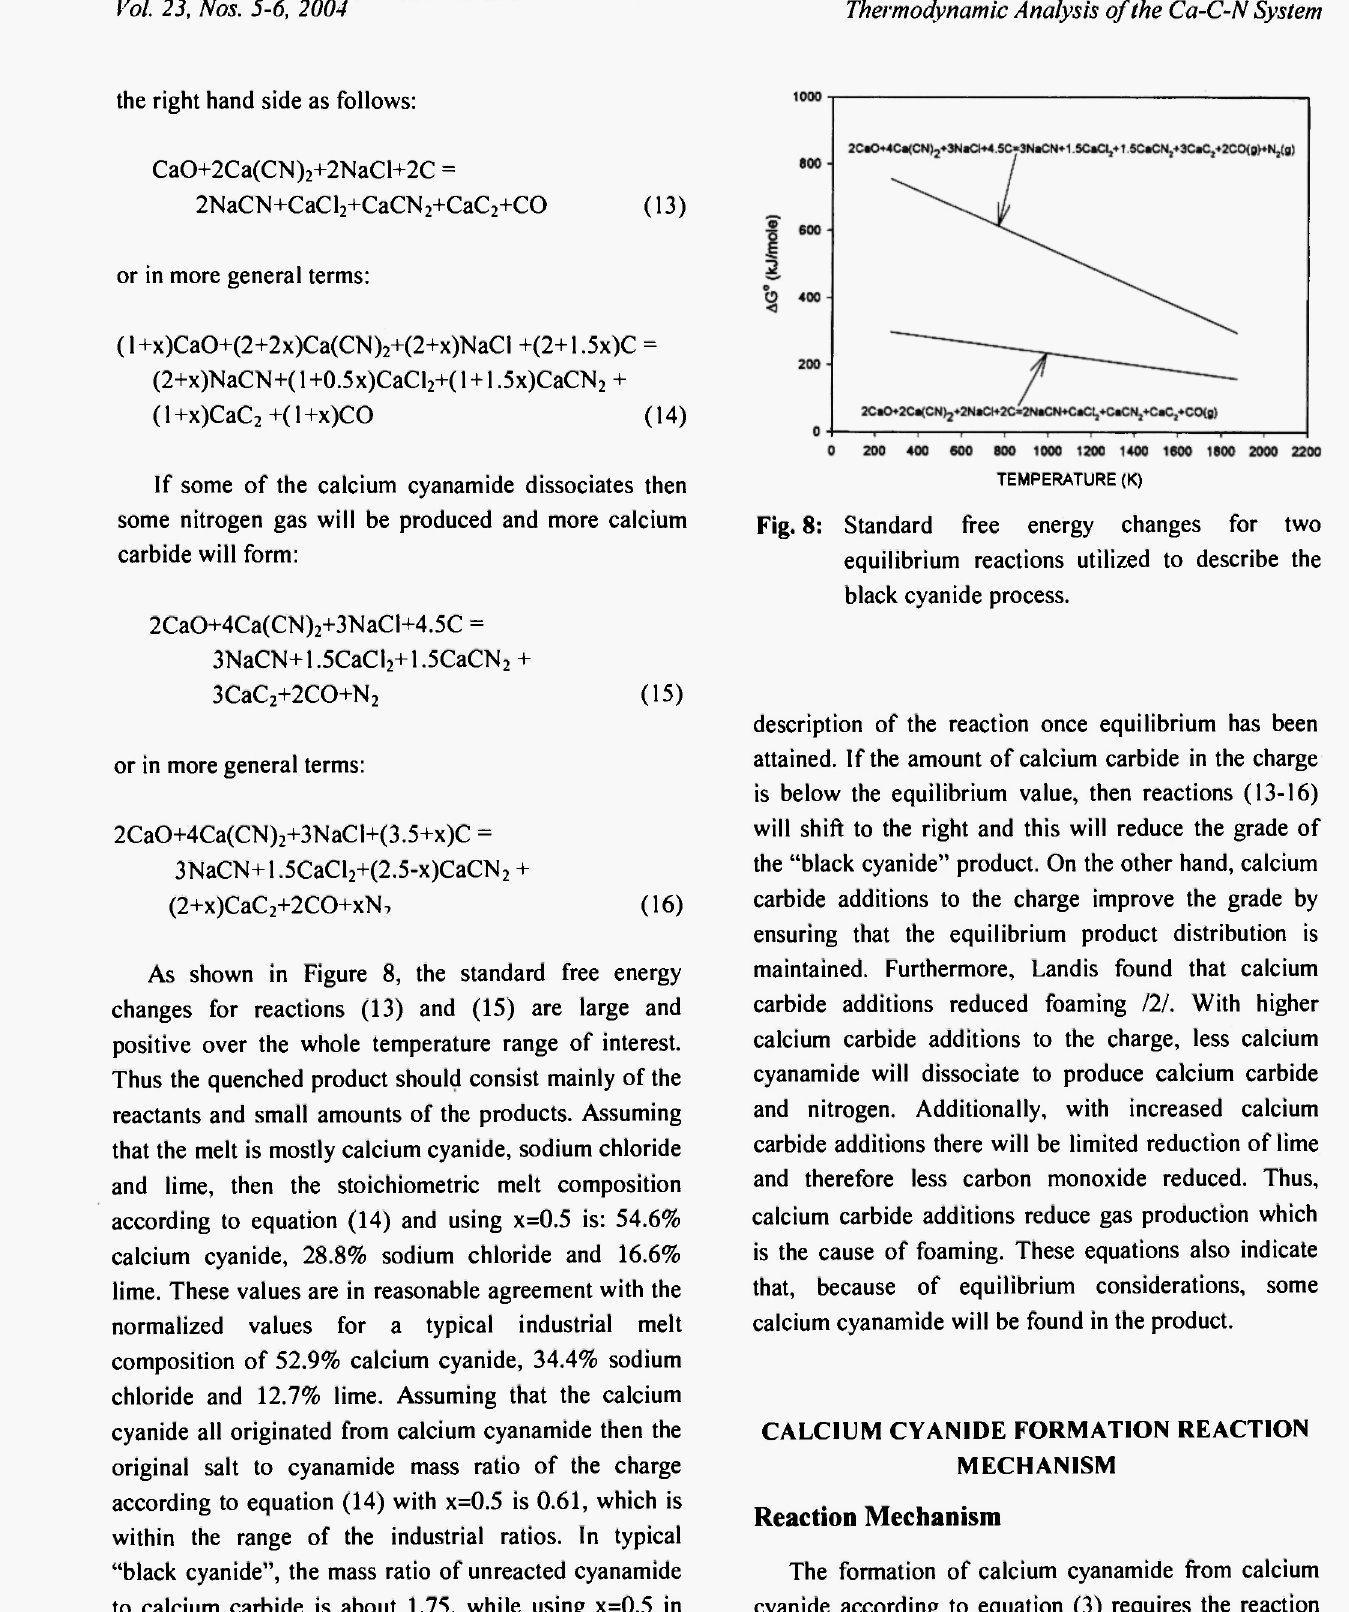
TEMPERATURE (K) Fig. 8: Standard free energy changes for two equilibrium reactions utilized to describe the black cyanide